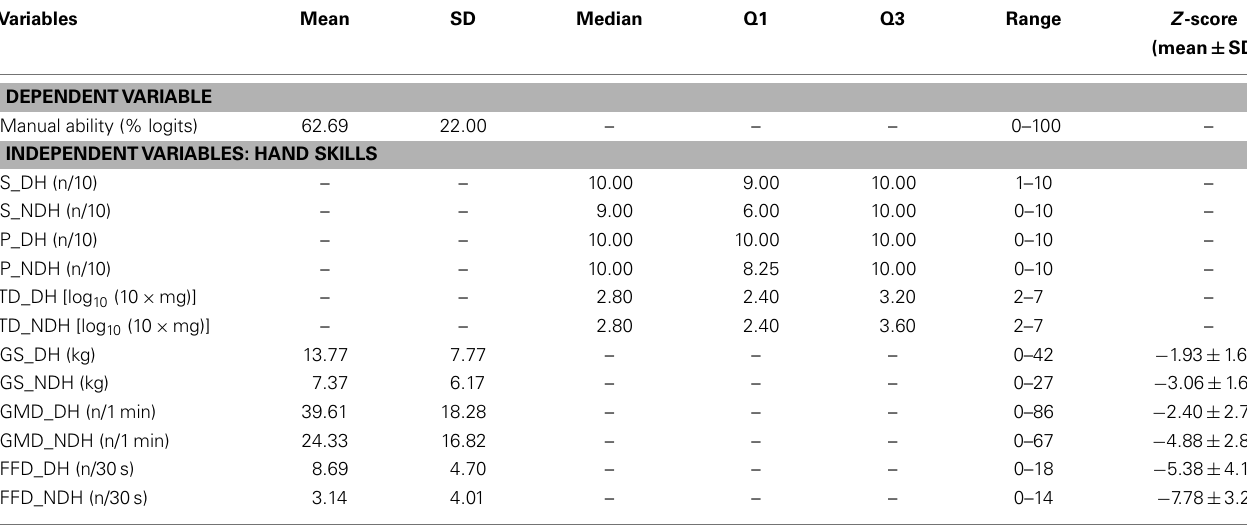
Table 2 | Descriptive statistics of manual ability and hand skills .